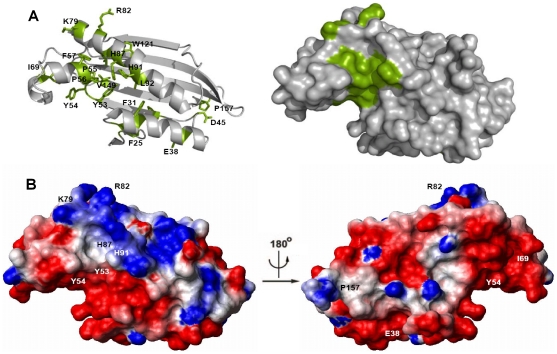
Position of the invariant residues of the Yer067w family in the three-dimensional structure.(A) Strictly conserved residues shown in Figure 1 are depicted in green with the respective lateral chain in the ribbon and space-filling diagram of Yer067w. Both diagrams are shown in the same orientation. Note the presence of a conserved cleft in Yer067w protein family. (B) Electrostatic surface charge distribution at pH 7.5 and 150 mM NaCl was calculated by Molmol. The positive and negative regions are shown in blue and red, respectively. The conserved, solvent-exposed residues are labeled. The first view is in the same orientation as shown in (A), while the second one shows the protein rotated through 180° along the vertical axis.